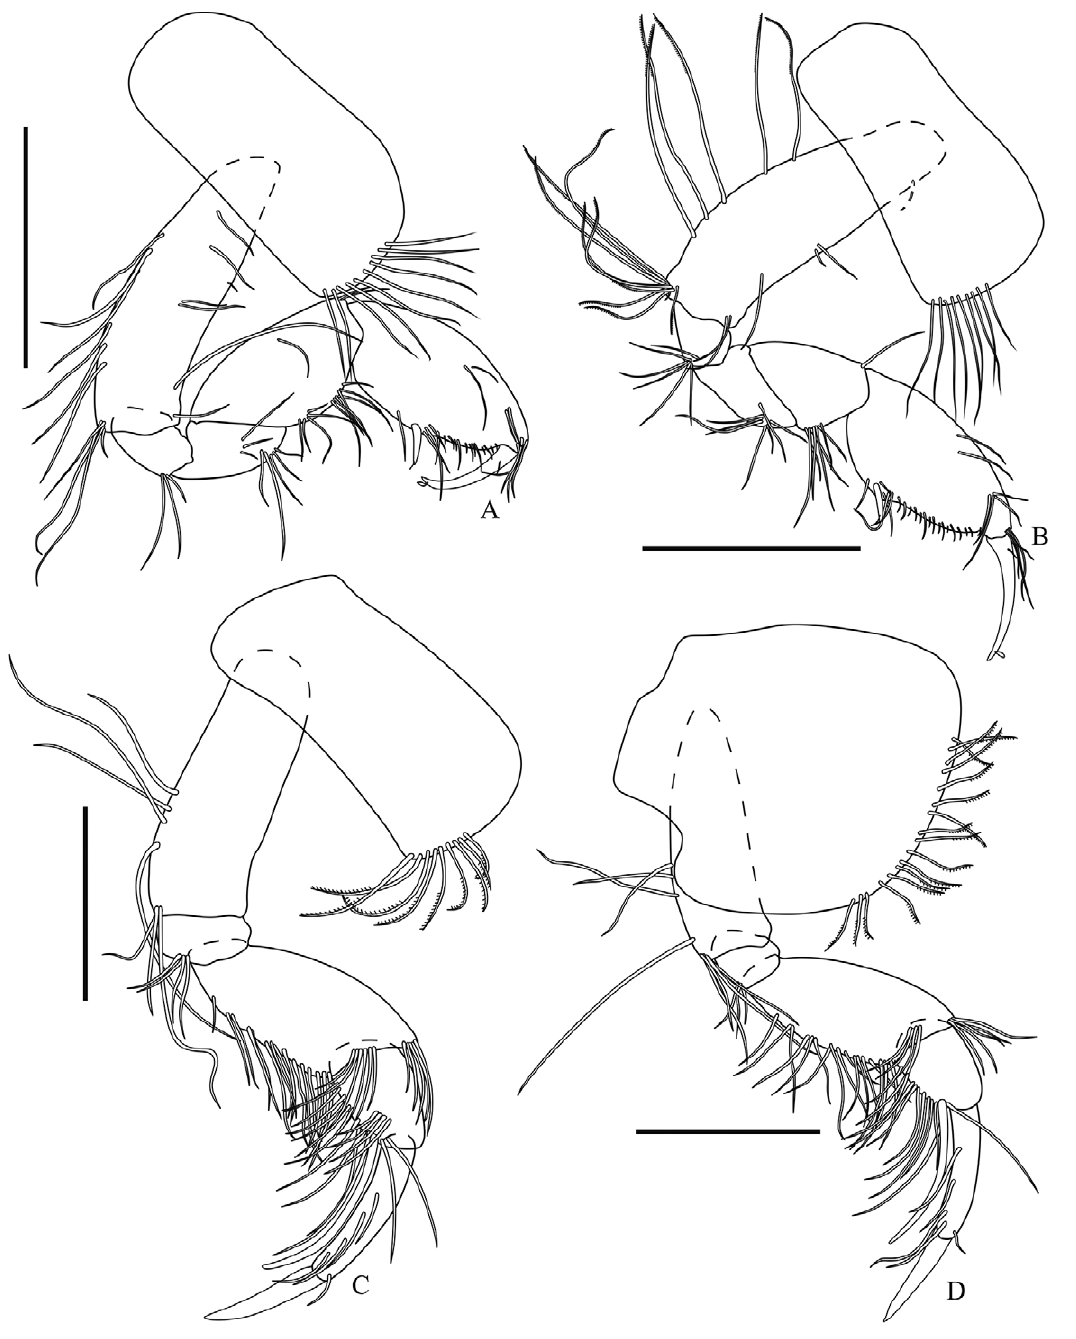
Fig. 3. – Atlantiphoxus wajapi n. sp. holotype female (UERJ 401). A, gnathopod 1; B, gnathopod 2; C, pereopod 3; D, pereopod 4. Scale bars: A-B: 0.2 mm, C-D: 0.5 dactylus subequal to palm, outer margin with 1 setule proximally and 1 spatulate seta distally. Pereopod 3 (Fig. 3C) coxa sub-rectangular, posterior margin weakly concave, ventral margin with 9 pectinate se- tae; basis about 2.8× longer than wide, posterior mar- gin with 4 setae medially, posterodistal corner with 3 setae; ischium small and sub-rectangular, postero- distal corner with 4 setae; merus anterior margin with 5 setae distally, posterior margin moderately setose, facial margin with a row of 6 setae distally; carpus